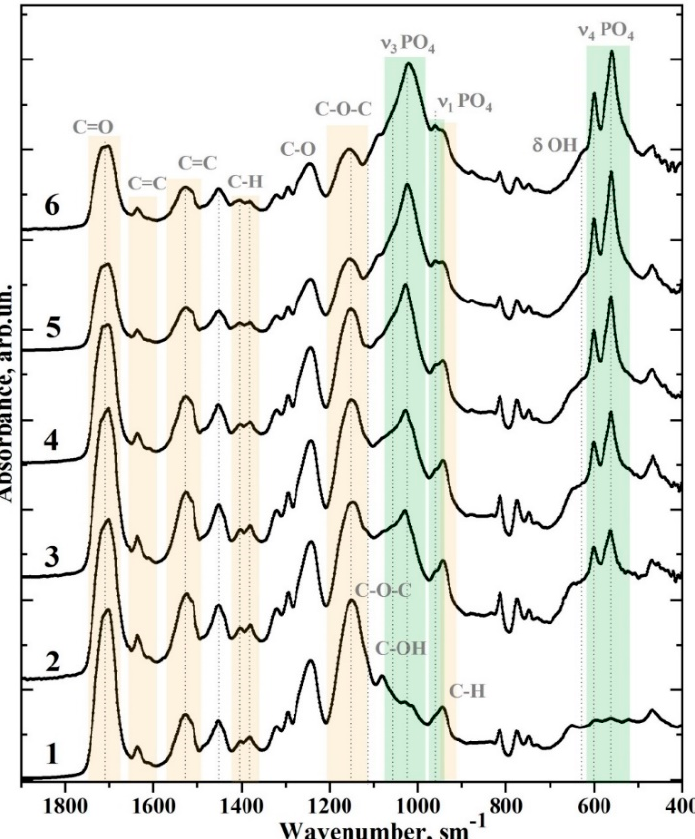
Figure 2. Comparison of FTIR spectra of dental biomimetic adhesives containing different amounts of nano-cHAp. (1) Sample #6 Bis-GMA/nano-cHAp (0.01 g); (2) sample #6 Bis-GMA/nano-cHAp (0.04 g); (3) sample #4 Bis-GMA/nano-cHAp (0.08 g); (4) sample #3 Bis-GMA/nano-cHAp (0.12 g); (5) sample #2 Bis-GMA/nano-cHAp (0.16 g); (6) sample #1 Bis-GMA/nano-cHAp (0.01